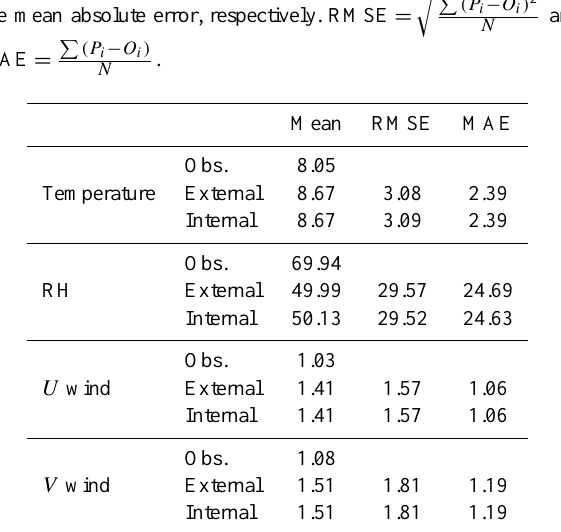
Table 3. Statistics of meteorological parameters predicted by exter- nal run and internal run for all observation sites within the 4km domain. RMSE and MAE are the root mean squared error and the mean absolute error, respectively. RMSE